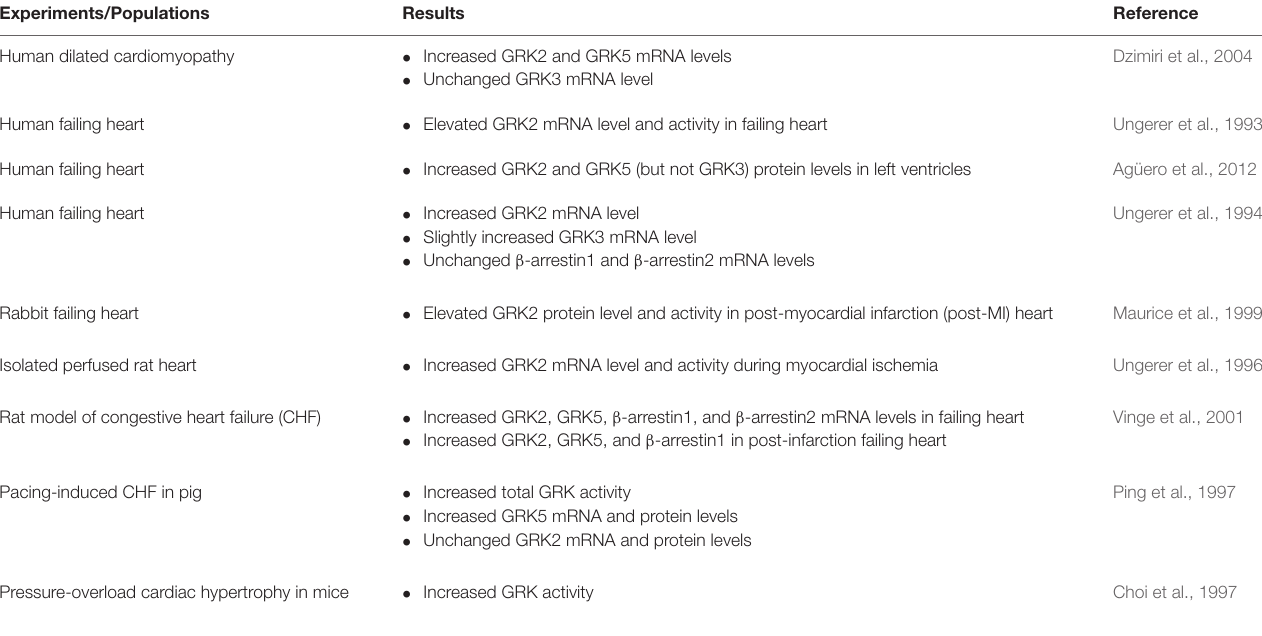
TABLE 1 | Changes in GRKs and β -arrestins levels and activities in animal models of HF and HF patients.